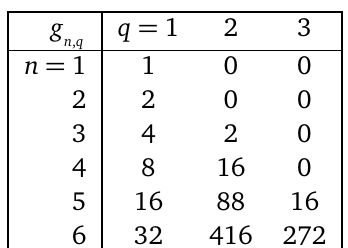
Table 1: The decomposition of the n ! Wightman basis correlators into the proper q -OTO correlators for low-lying values of n . g n , q